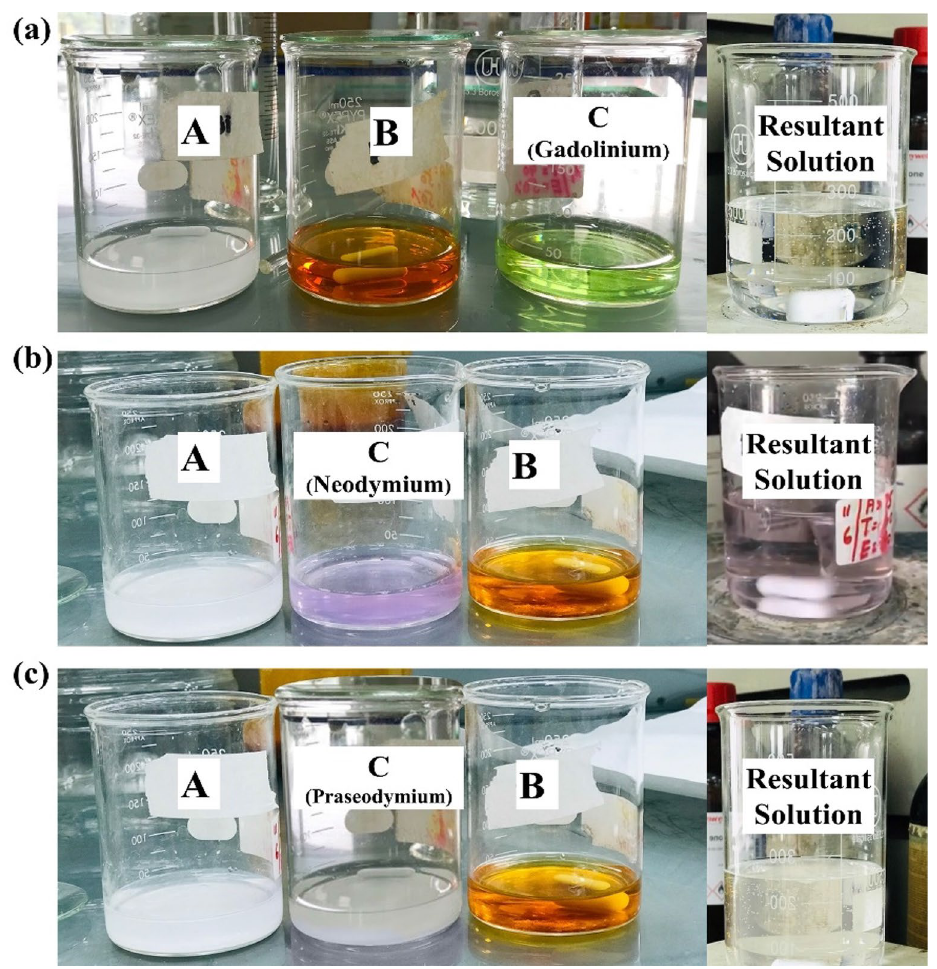
Figure 2. Doping of metal oxides with rare earth metals: Bi and Fe solutions with rare earth metals as ( a ) Gd solution and Gd doped BiFeO 3 , ( b ) Nd solution and Nd doped BiFeO 3 , and ( c ) Pr solution and Pr doped BiFeO 3